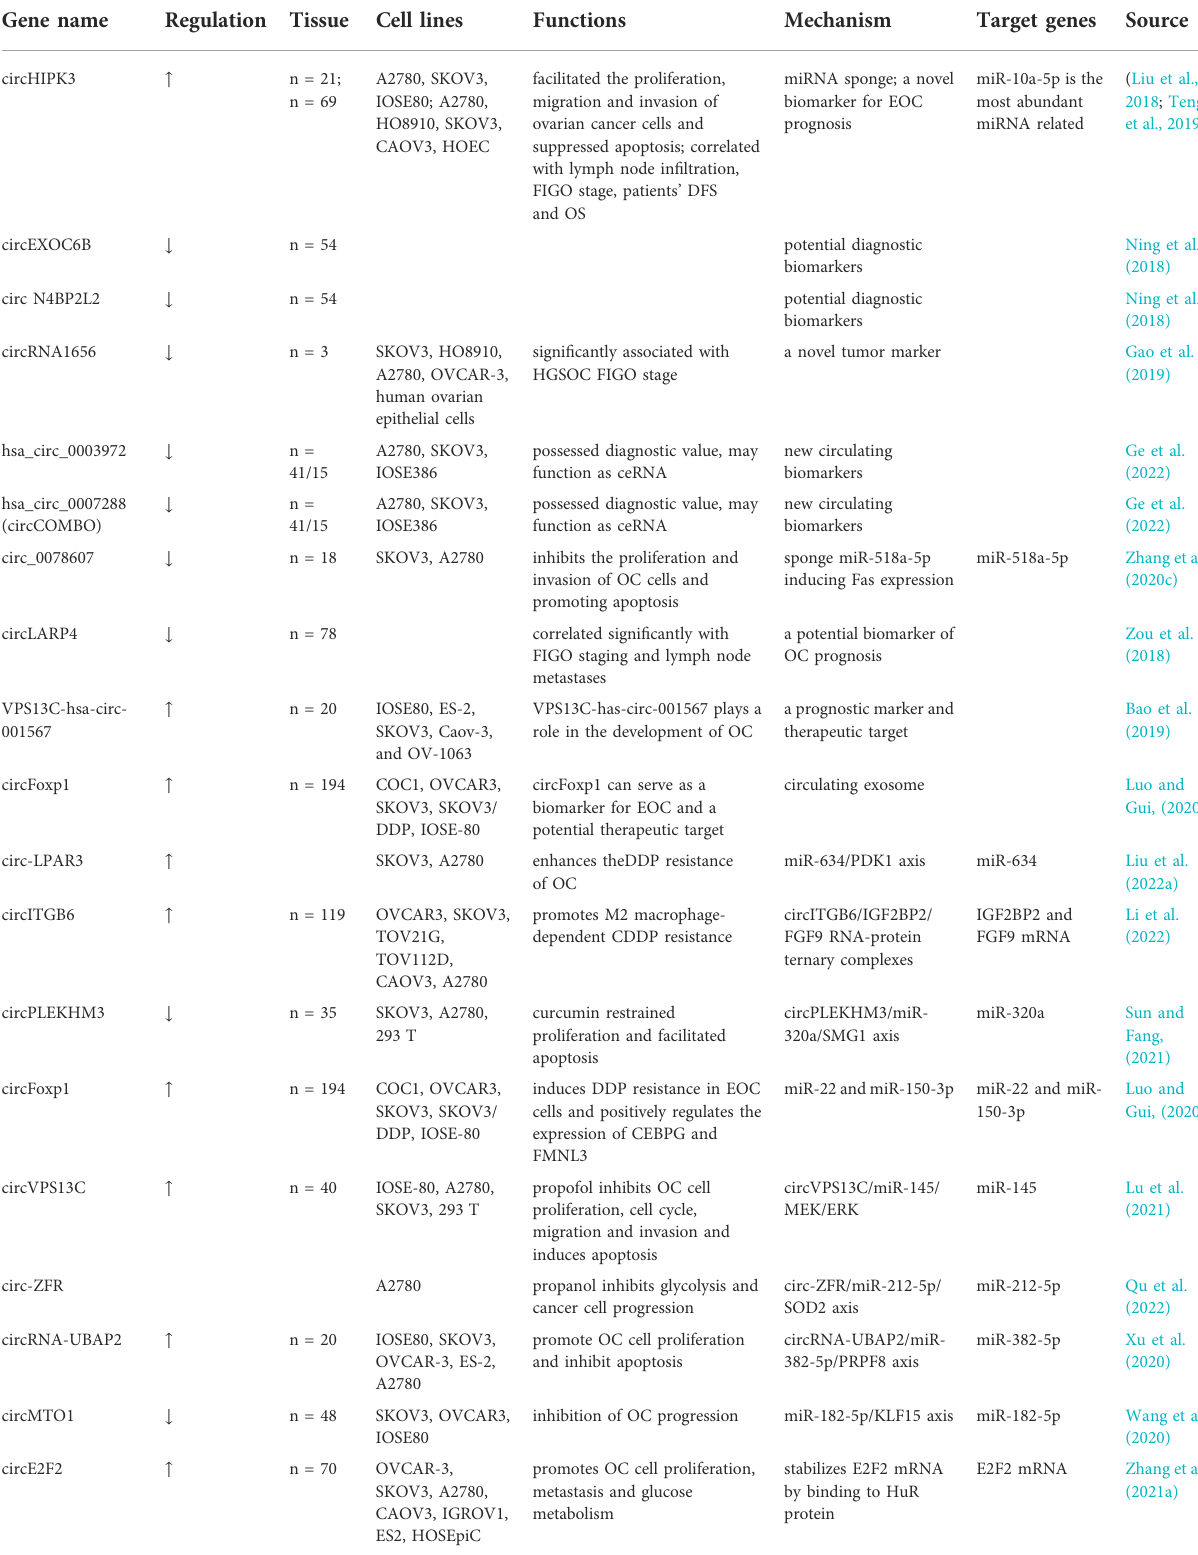
TABLE 1 The list of circRNAs in